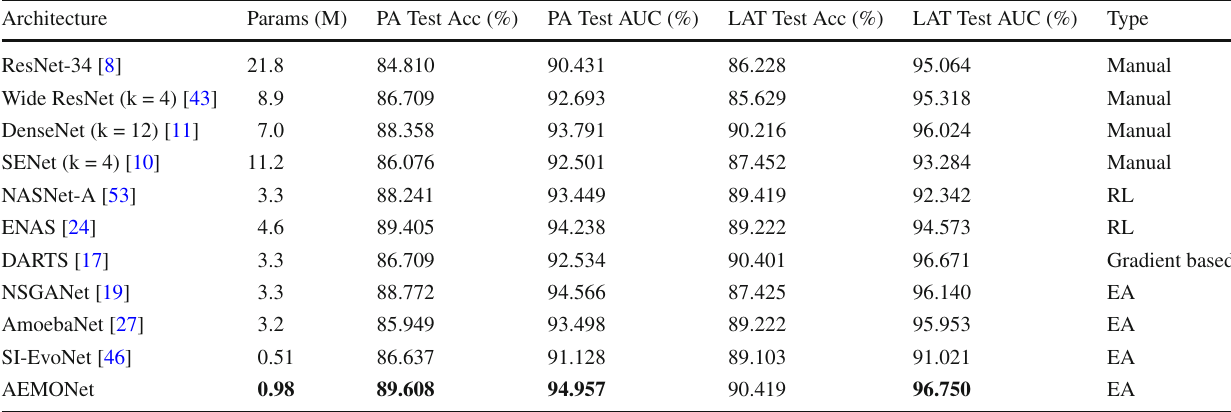
† PA represents anteroposterior view; LAT represents Lateral view Bold highlights the performance effects of our algorithm and the corresponding improvement